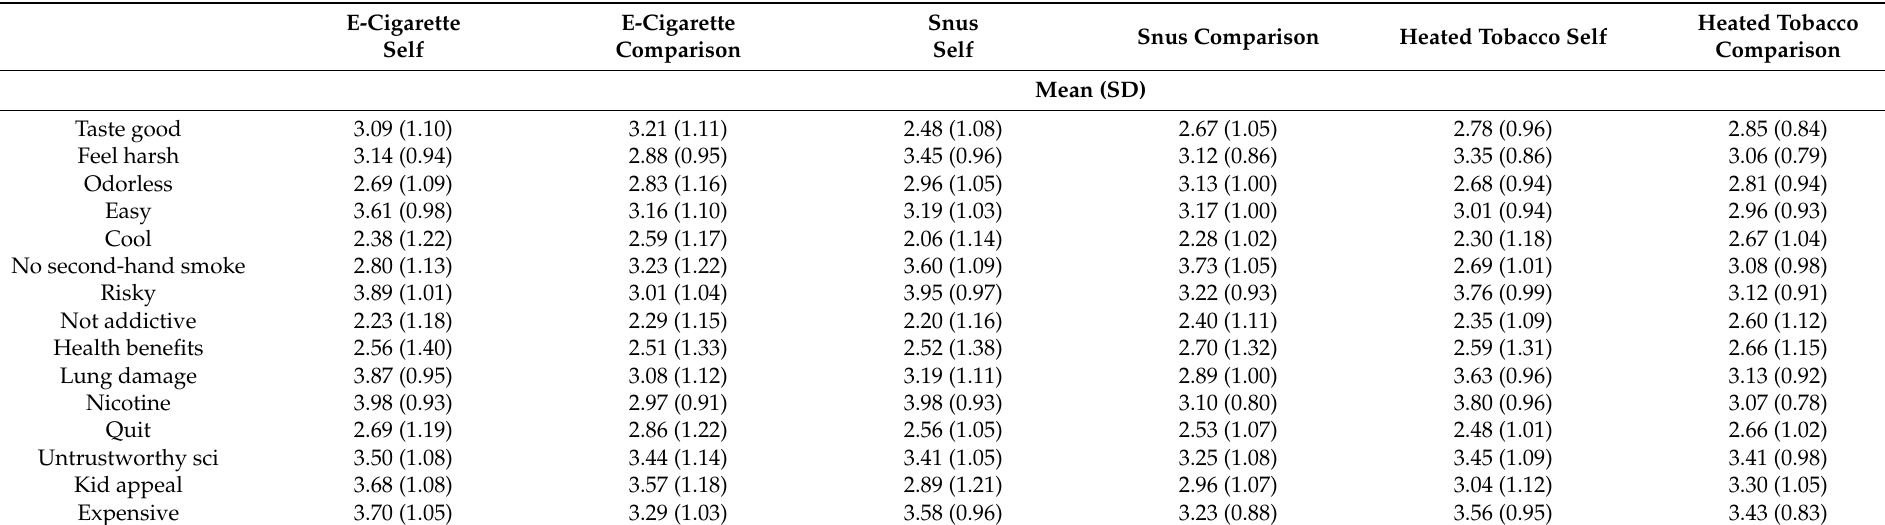
Table 4. Mean belief endorsement for the 15 close-ended belief items about e-cigarettes, snus, and heated tobacco n =